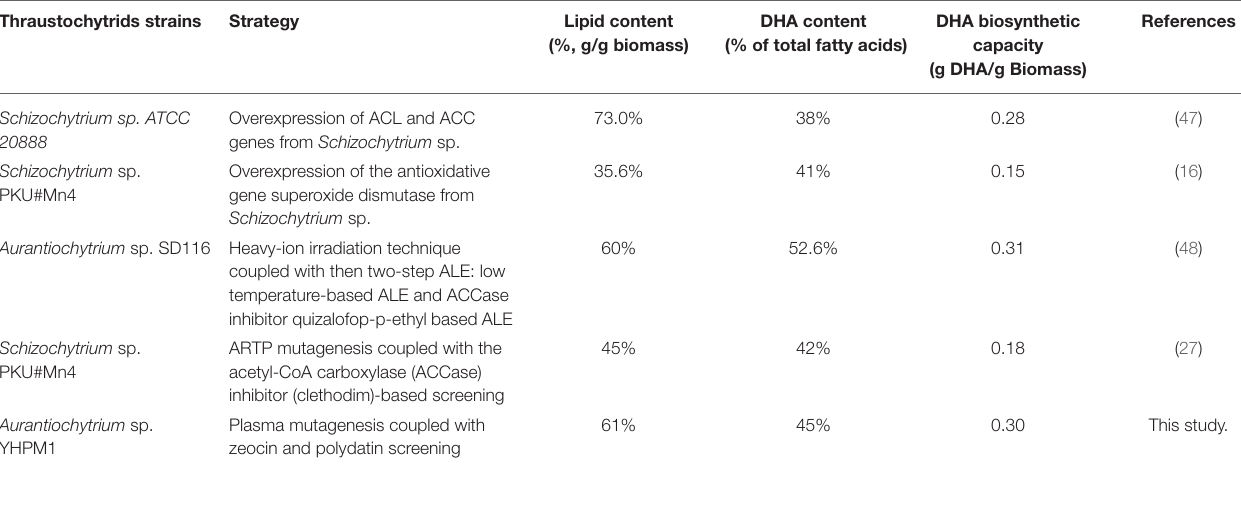
TABLE 2 | Different metabolic engineering strategies to enhance docosahexaenoic acid (DHA) production from thraustochytrid strains. Thraustochytrids